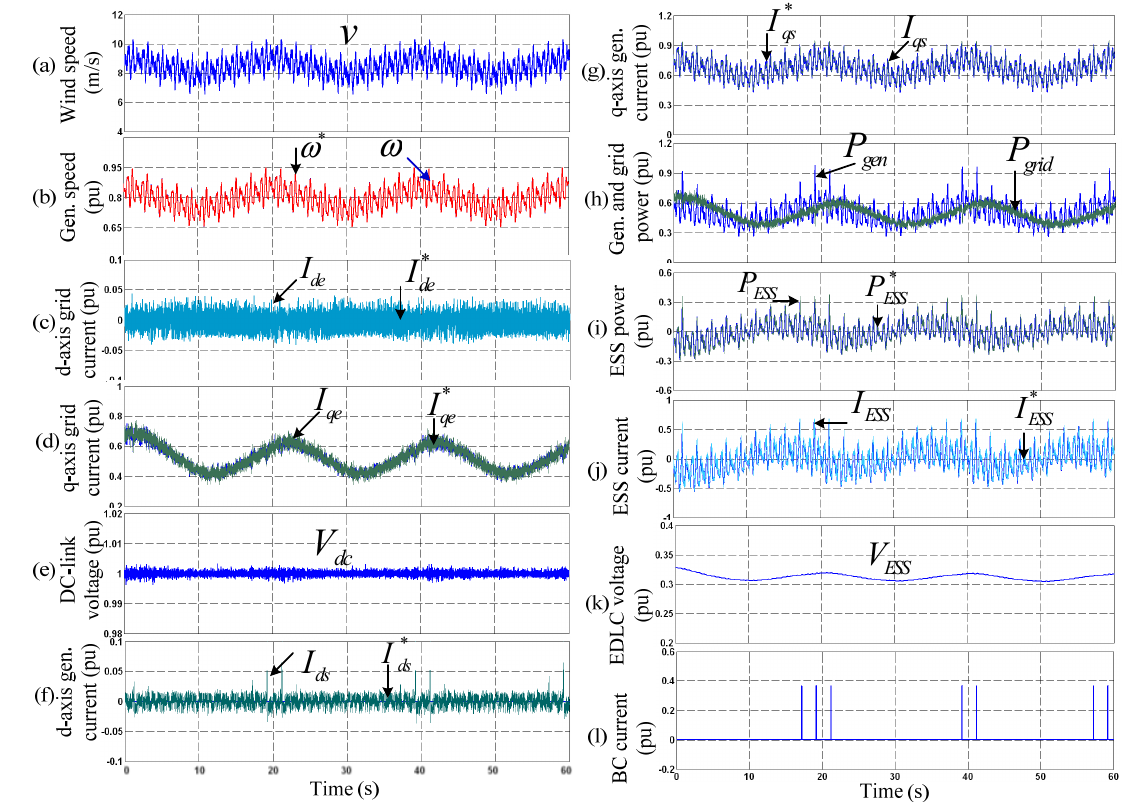
Figure 7. Power fluctuation mitigation performance. ( a ) Wind velocity pattern. ( b ) PMSG speed. ( c ) d-axis grid currents. ( d ) q-axis grid currents. ( e ) DC-link voltages. ( f ) d-axis currents of PMSG. ( g ) q-axis currents of PMSG. ( h ) Generator and grid powers. ( i ) ESS power. ( j ) EDLC current. ( k ) EDLC voltage. ( l ) BR current.